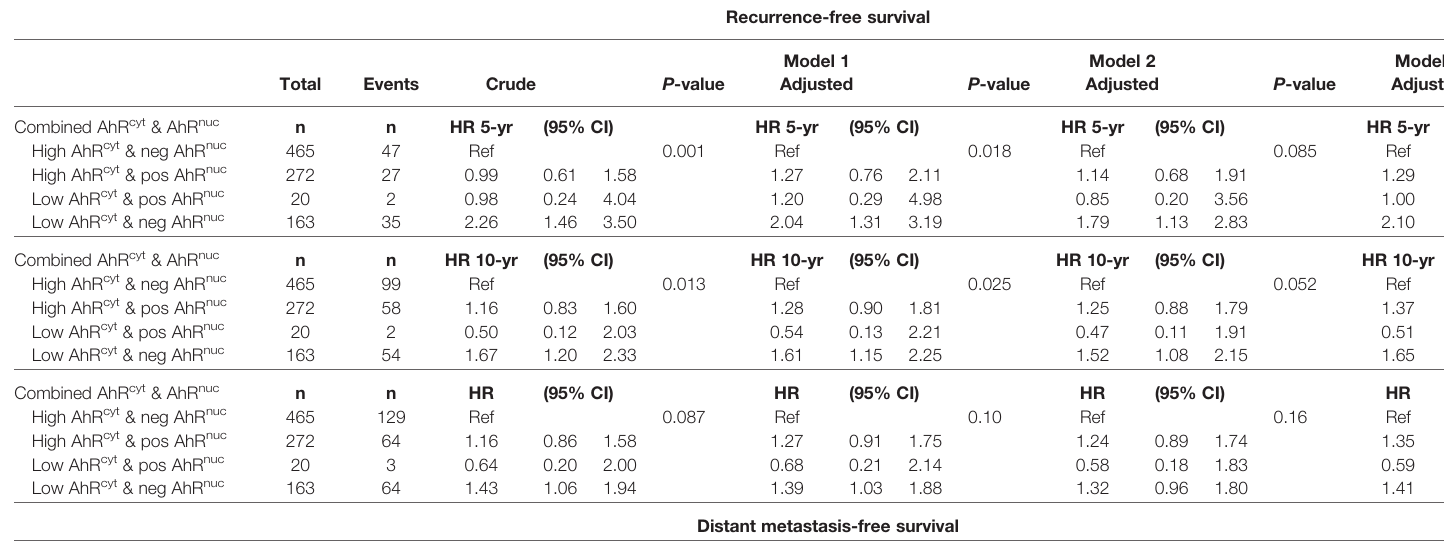
TABLE 3 | Multivariable models with crude and adjusted HR (95% CIs) for combined AhR cyt and AhR nuc in relation to RFS and DMFS for 5-yr, 10-yr, and the entire follow-up.